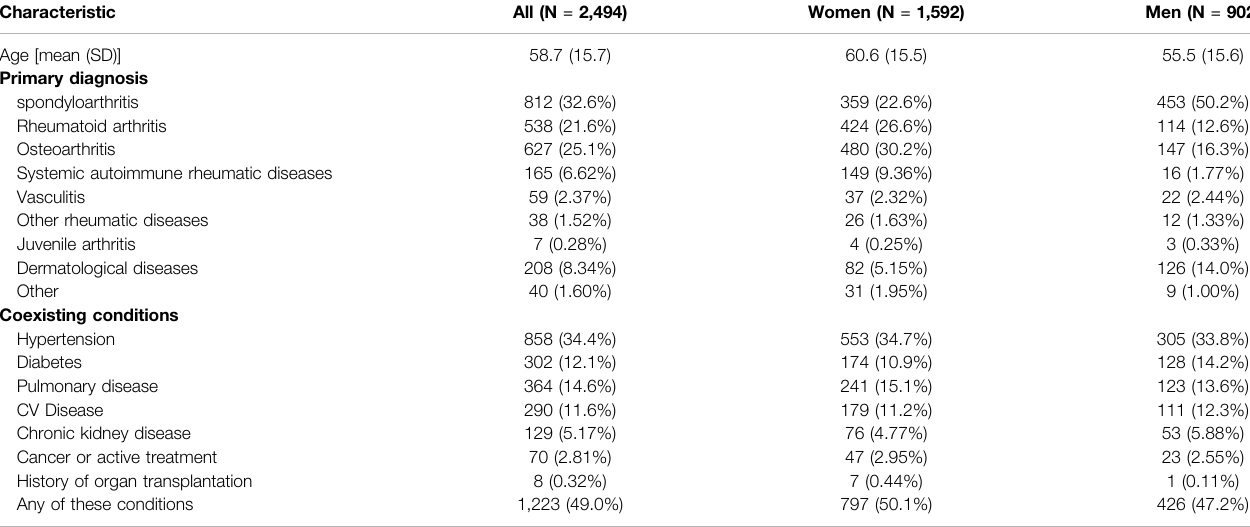
TABLE 1 | Characteristics of the study population [N